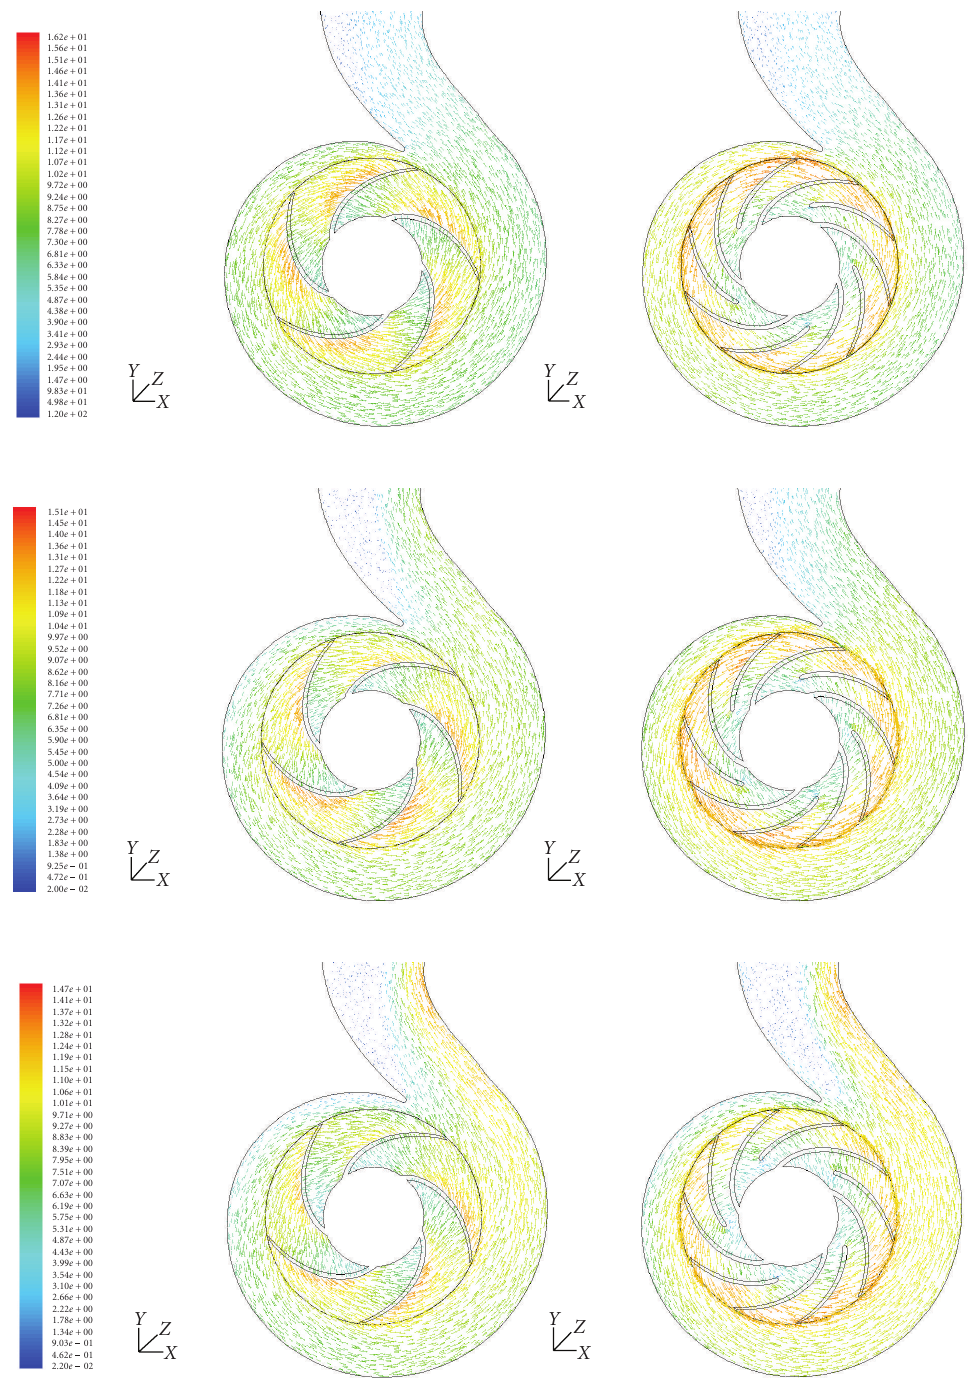
Figure 10: Computed velocity fields at 80% (top), 100% (center), and 120% (bottom) of BEP at mean plane ( z = 0) for original (left) and splittered (right)